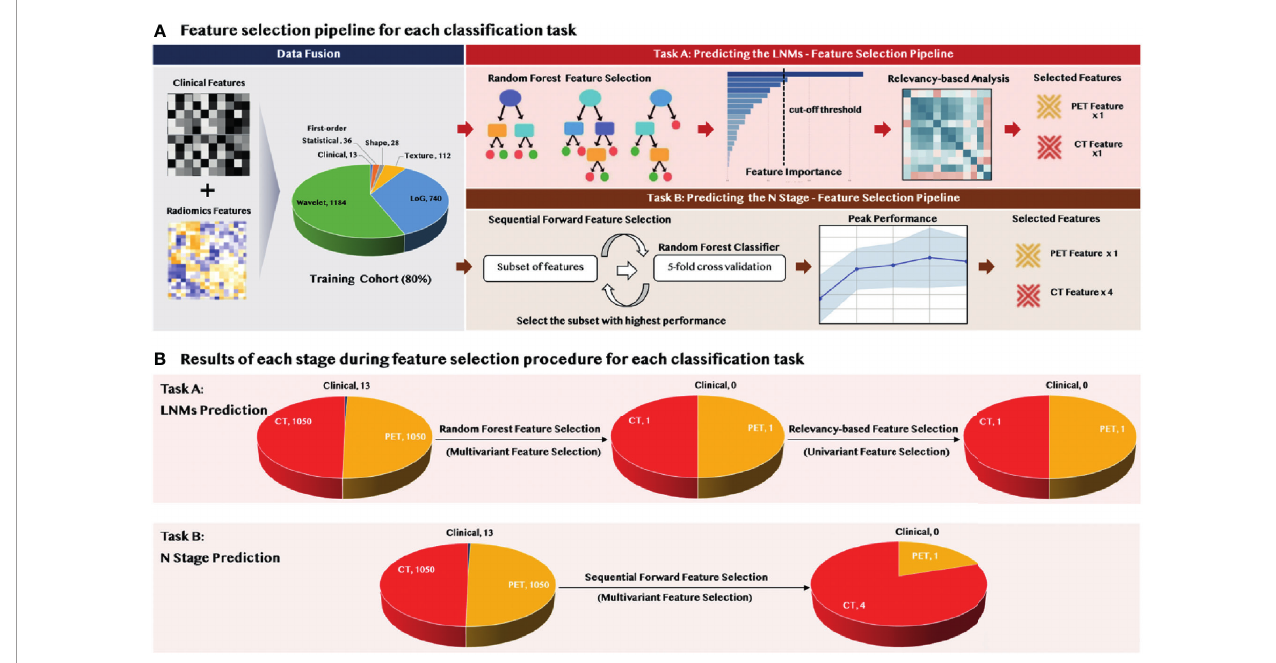
FIGURE 2 | Methodology and the results of feature selection: (A) feature selection pipeline, and (B) number of selected features during the selection